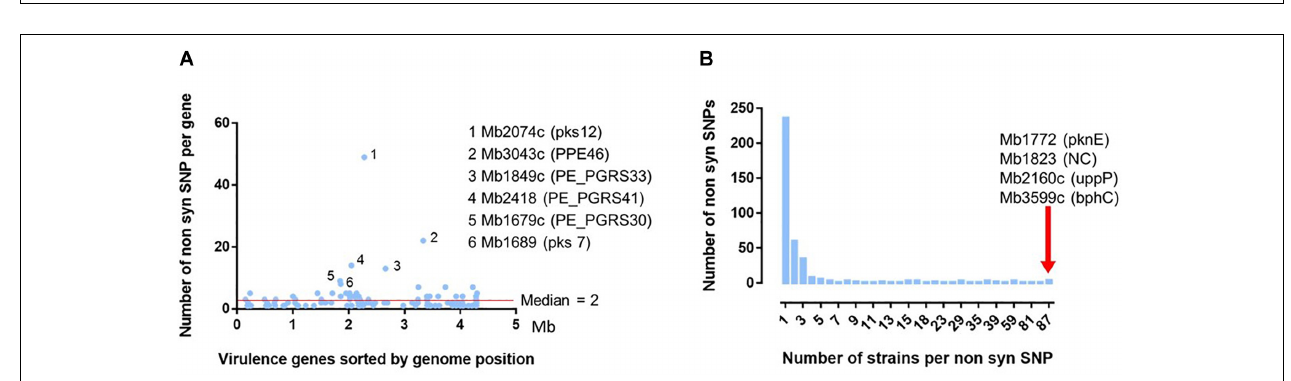
FIGURE 5 | Overview of the distribution of the 392 variant non-synonymous SNPs detected in the 131 virulence genes by comparison of the M. bovis strain AF2122/97 and the 87 French M. bovis field isolates. The map was generated with Bionumerics software. Each circle corresponds to a pseudosequence of the polymorphic 392 non-synonymous SNPs detected on the 131 virulence genes of one strain. From outer to inner: strain AF2122/97 then the 87 field isolates arranged by their genetic Cluster, from A to I. The base changes are shown, A in green, C in blue, G in black, and T in red.